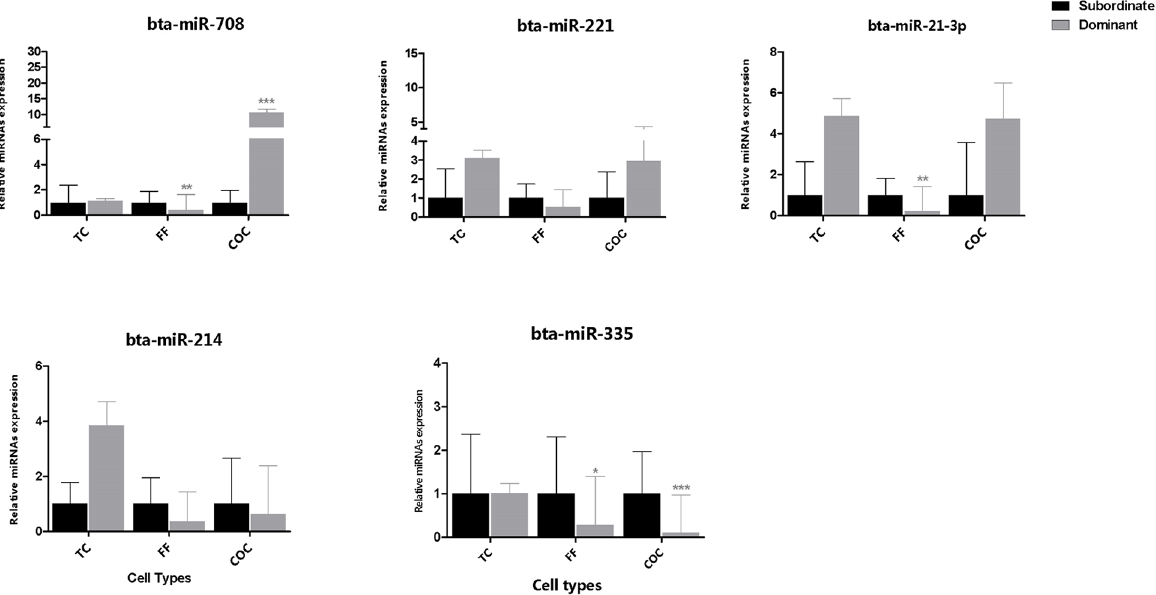
Fig 7. Expression pattern of bta-miR-708, bta-miR-221, bta-miR-21-3p, bta-miR-214 and bta-miR-335 in companion follicular cells of both preovulatory dominant and subordinate follicles using qPCR. The mean expression value of target miRNA was normalized against the expression of endogenous control U6 snRNA and 5s rRNAs. Relative expression values were calculated using ΔΔ CT method. Error bars represent SD of ΔΔ CT values. Statistical significance of each miRNA are represented by asterisks; * , p < 0.05, ** , p < 0.01 and *** , p < 0.001. Legend: TC = Theca cells COC = cumulus- oocyte-complex FF = follicular fluid.